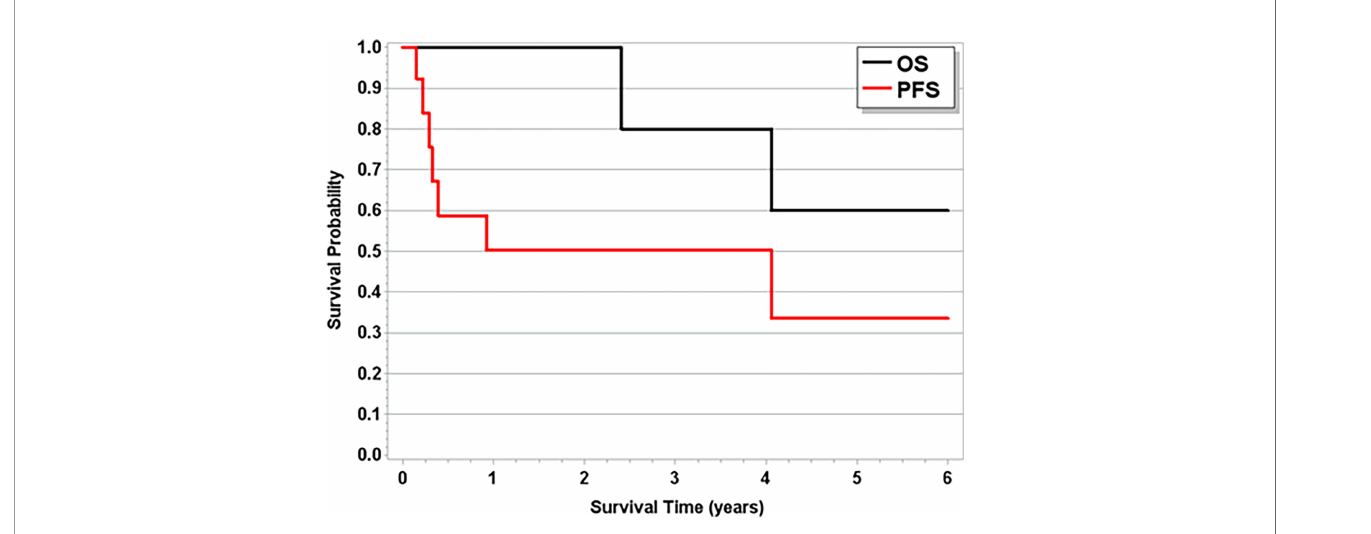
FIGURE 1 | Overall Survival and Progression Free Survival for Entire Cohort.